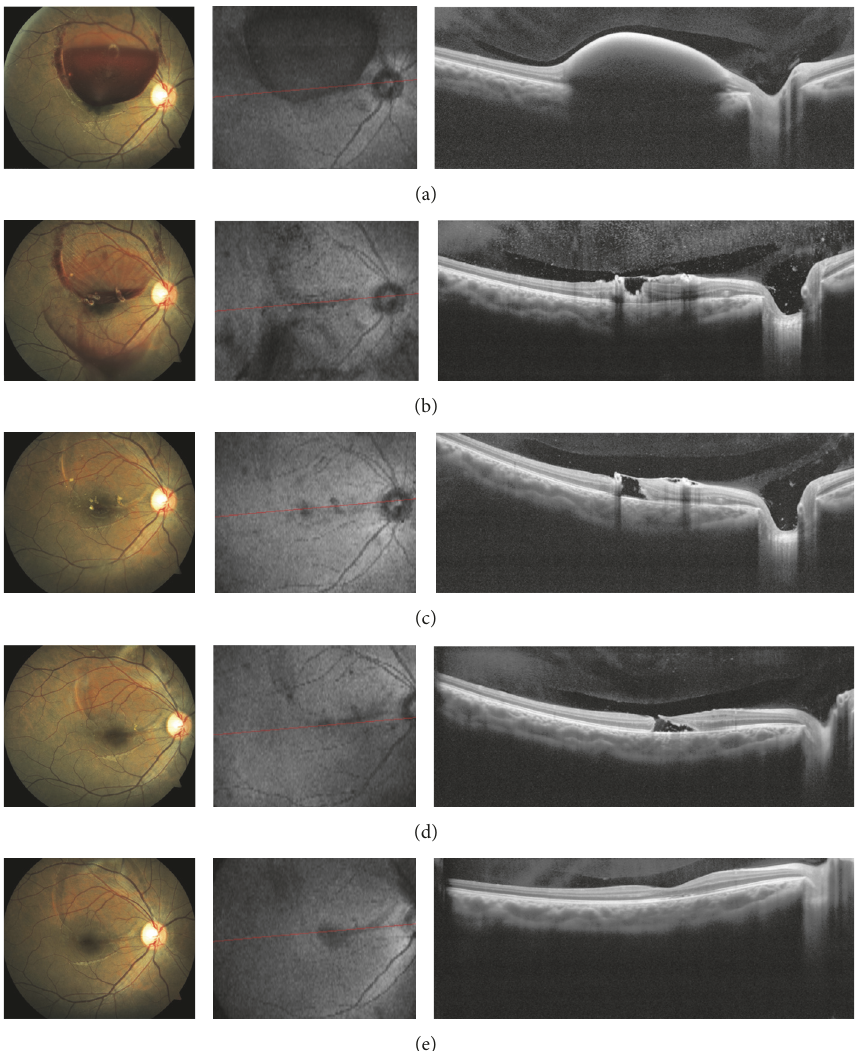
Figure 1: Valsalva retinopathy in the right eye, colour fundus photographs, and Enhanced Deep Image (EDI) optical coherence tomography (OCT)cross-sections.(a)BeforeNd:YAGlasermembranotomy.(b)1sthouraftertheprocedure.(c)Atweek1,laserspotsitesaredistinguished in the fundus, full-thickness macular hole in the EDI-OCT. (d) At month 3, full-thickness macular hole persisted. (e) At month 6, macular hole closed